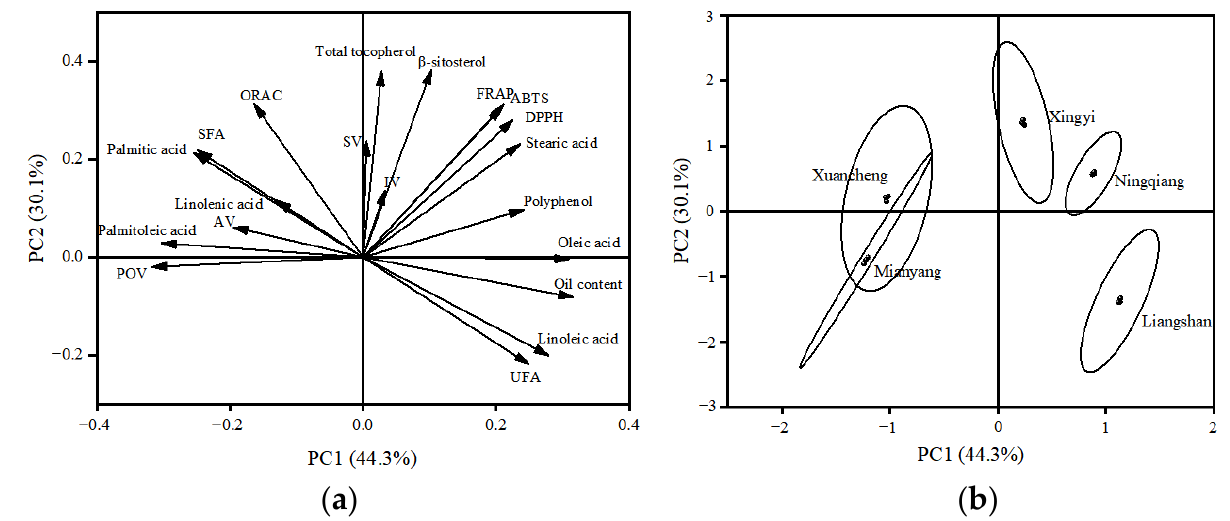
Figure 1. Multivariate general characterization of IPPO from five regions by PCA. Plots of coefficient ( a ), and cultivar ( b ).